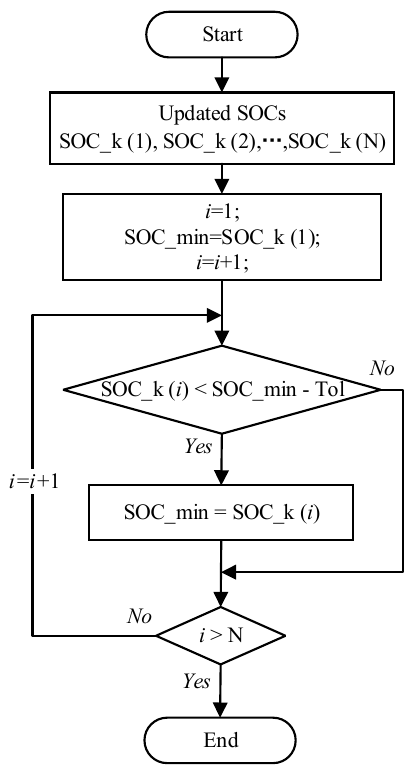
Figure 4. Flowchart of the adopted balancing algorithm.